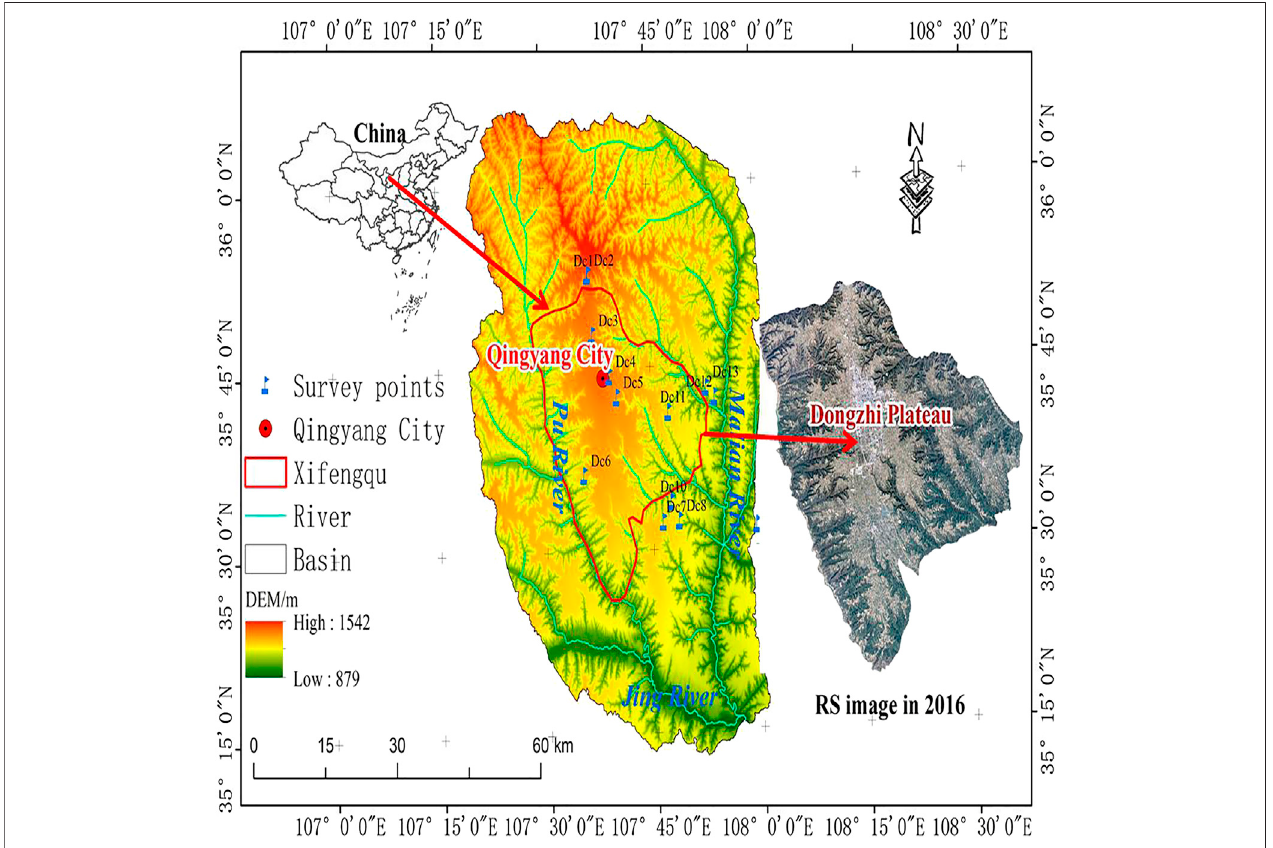
FIGURE 1 | Study areas. Map showing the surrounded hydro-geomorphology and the general situation of the stream network. DEM: digital elevation model; RS: remote sensing.